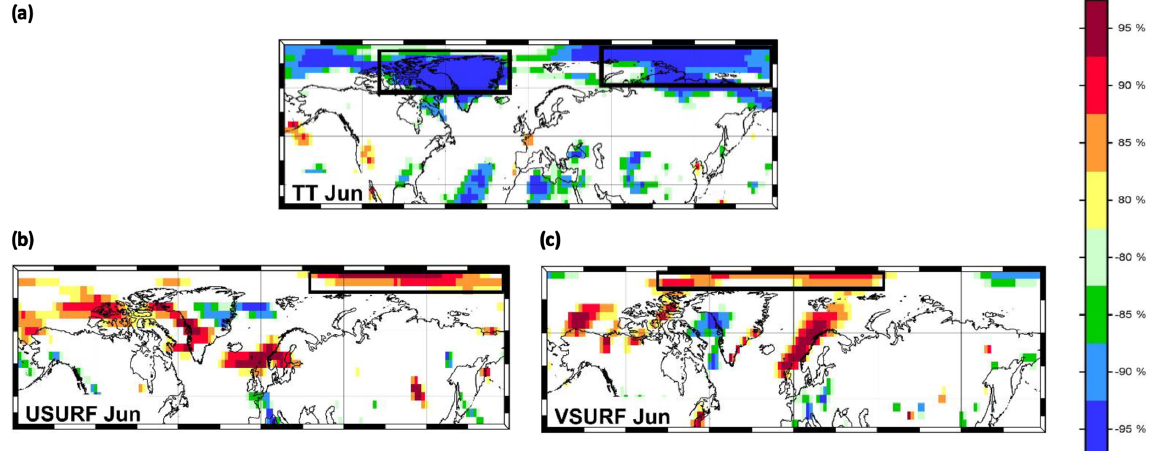
Figure 2. Stability map of the correlation between September sea ice extent and (a) TT Jun, (b) USURF Jun and (c) VSURF Jun. Regions where the correlation is stable, positive and significant for at least 80% of the 21-year windows are shaded with dark red (95%), red (90%), orange (85%) and yellow (80%). The corresponding regions where the correlation is stable, but negative, are shaded with dark blue (95%), blue (90%), green (85%) and light green (80%). The black boxes indicate the regions used for the September sea ice extent at the end of June in addition to the variables of May.